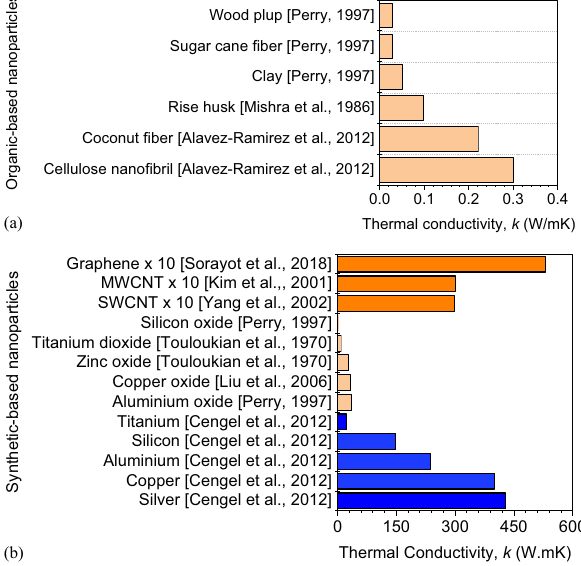
Figure 1: Thermal conductivity of various types of nanoparticles: ( a ) organic - based nanoparticles and ( b ) synthetic - based